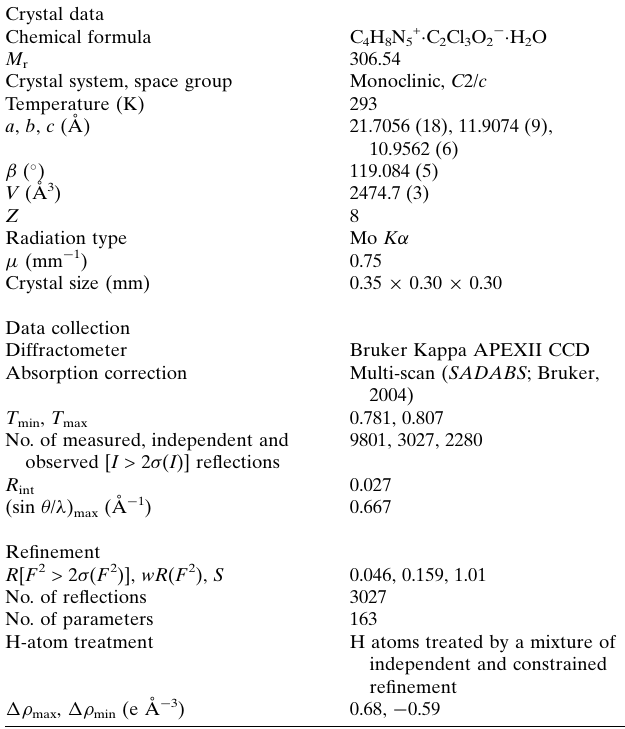
Crystal data Chemical